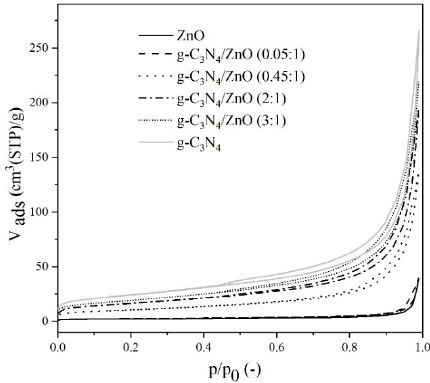
/ 3 N 4 , and g-C 3 N 4